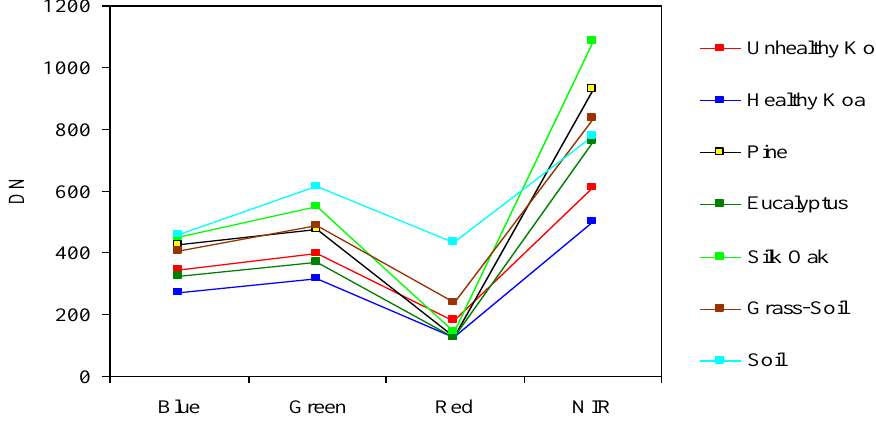
Figure 3. Pseudo-spectral signatures of tree species and land cover classes across the visible and NIR spectral bands in digital numbers